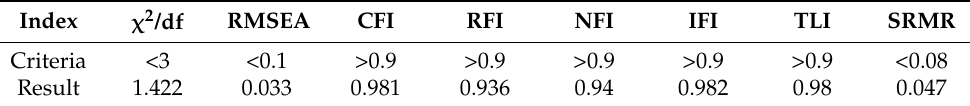
Table 6. Results of model fit.